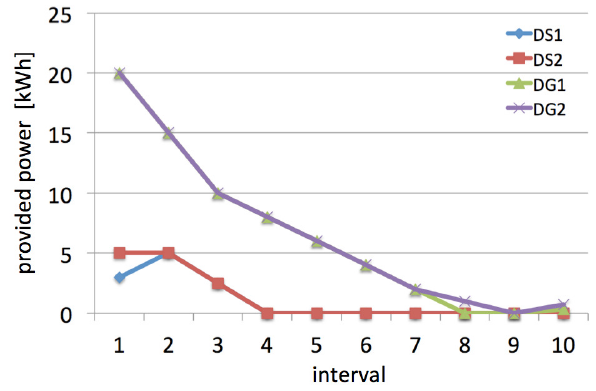
Figure 9. The transition of the power